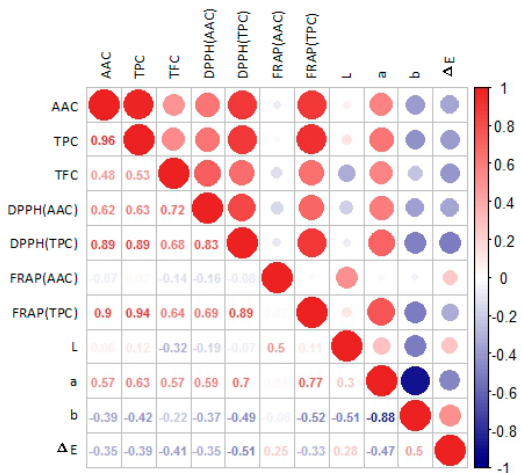
Figure 4. Correlation heat map of the antioxidant analysis.